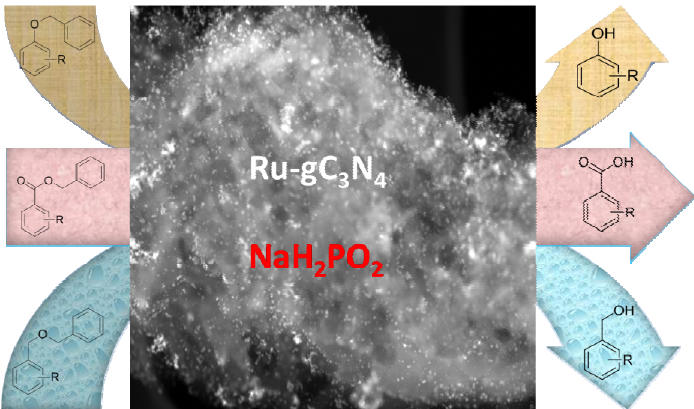
Figure 1. Schematic representation of Ru ‐ GCN catalyzed hydrodebenzylation reaction.